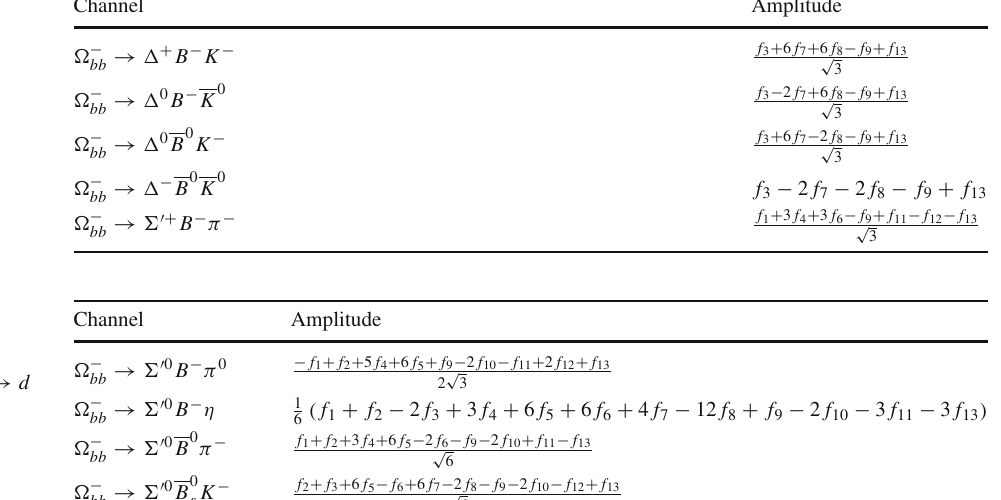
Channel Amplitude (cid:5) − → (cid:6) (cid:4) 0 B − π 0 bb